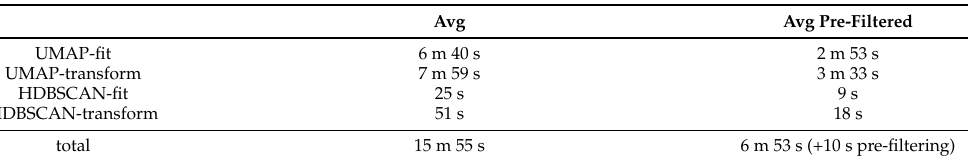
Table A7. This table gives an overview of the average run-time per sample for the full sample and for the pre-filtered